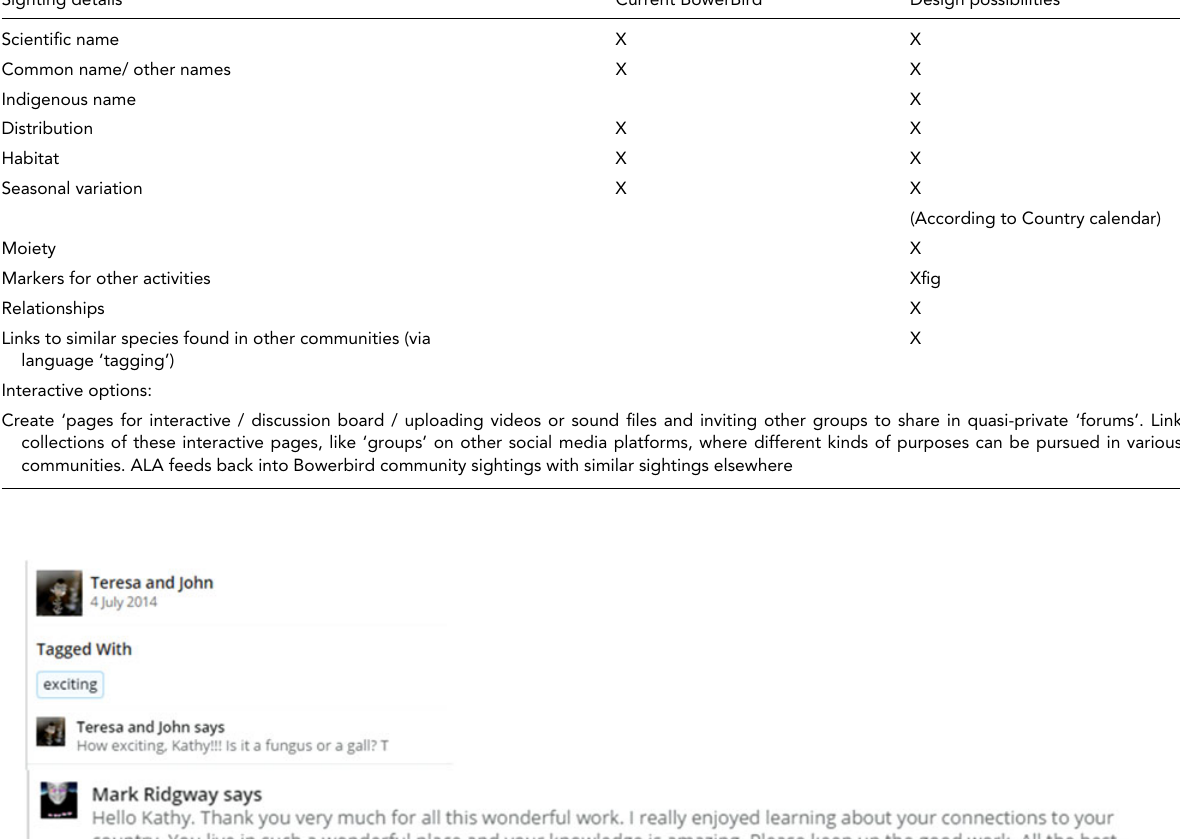
TABLE 1 Options for Design Sighting details